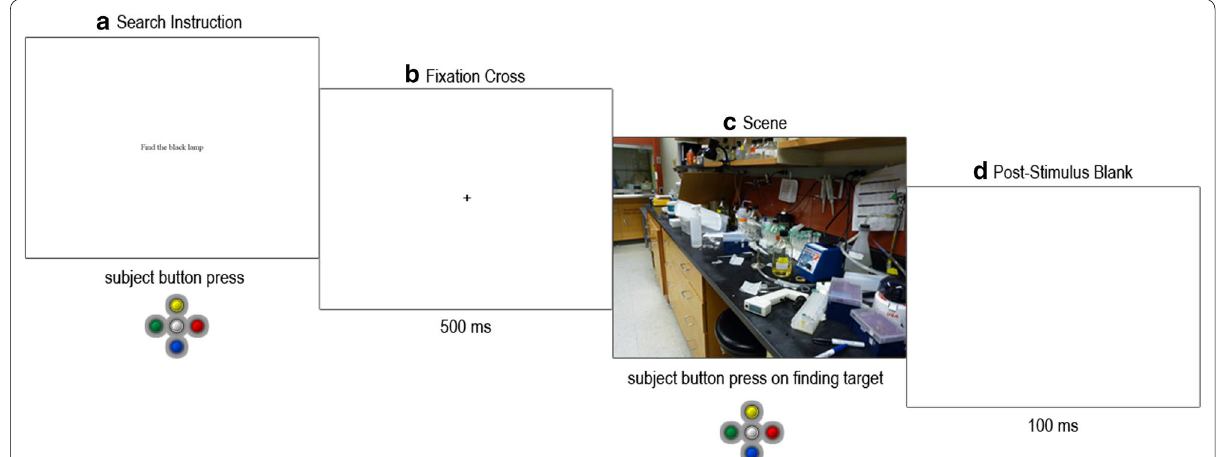
Fig. 2 Trial procedure schematic. a The search instruction (e.g., Find the black lamp ) was presented in the center of the screen until the subject pressed a button to proceed. b A central fixation cross was presented for 500 ms. c The scene was presented until the subject pressed a button to indicate that the target object had been found. d A blank screen was presented for 100 ms, after which the trial procedure